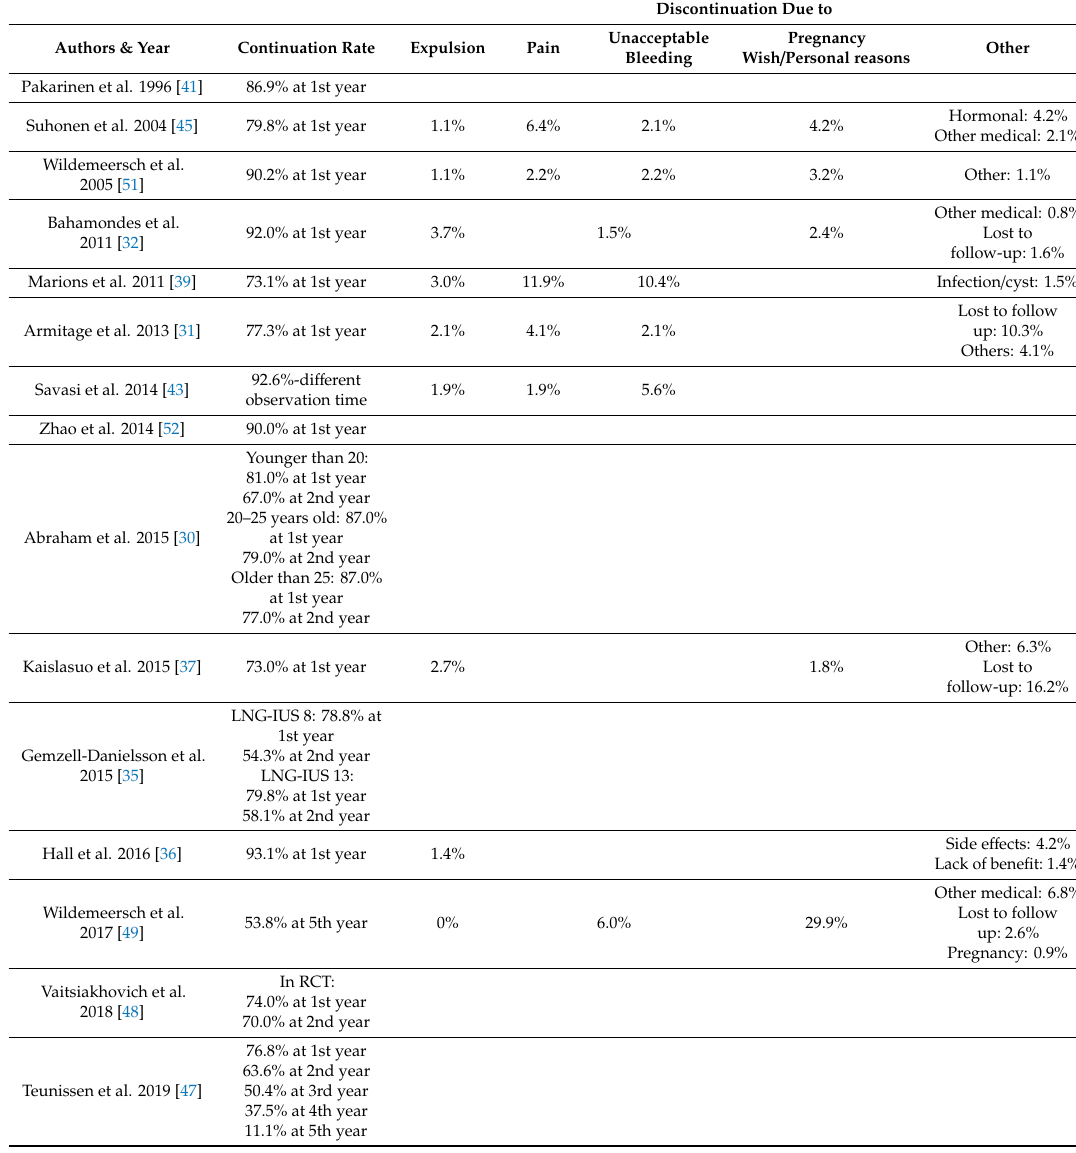
Table 3. Continuation rates and reasons for